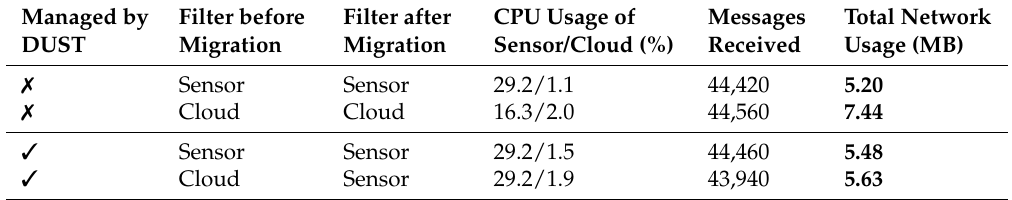
Table 2. Network optimization of use case 1.